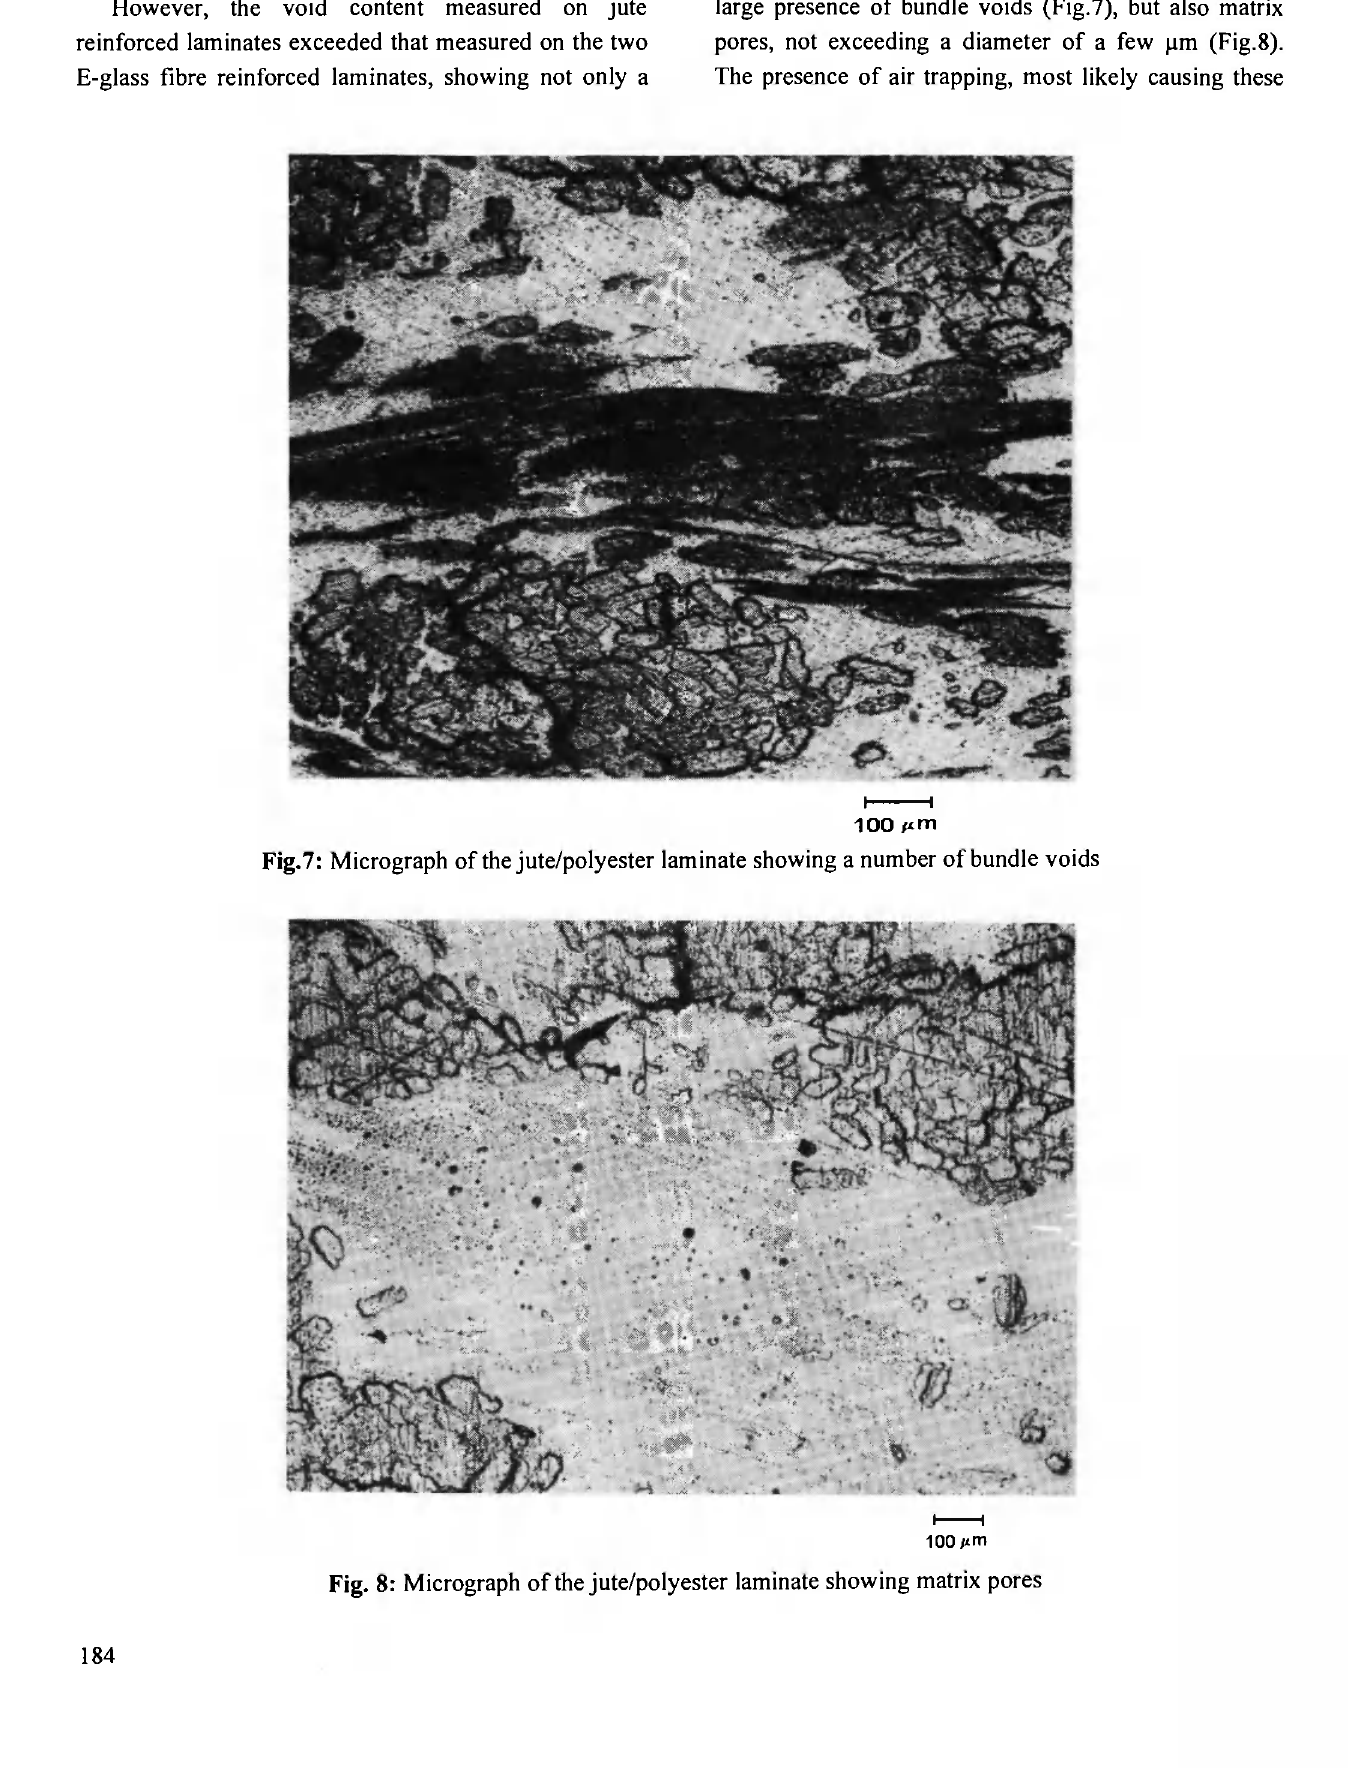
Fig.7: Micrograph of the jute/polyester laminate showing a number of bundle voids